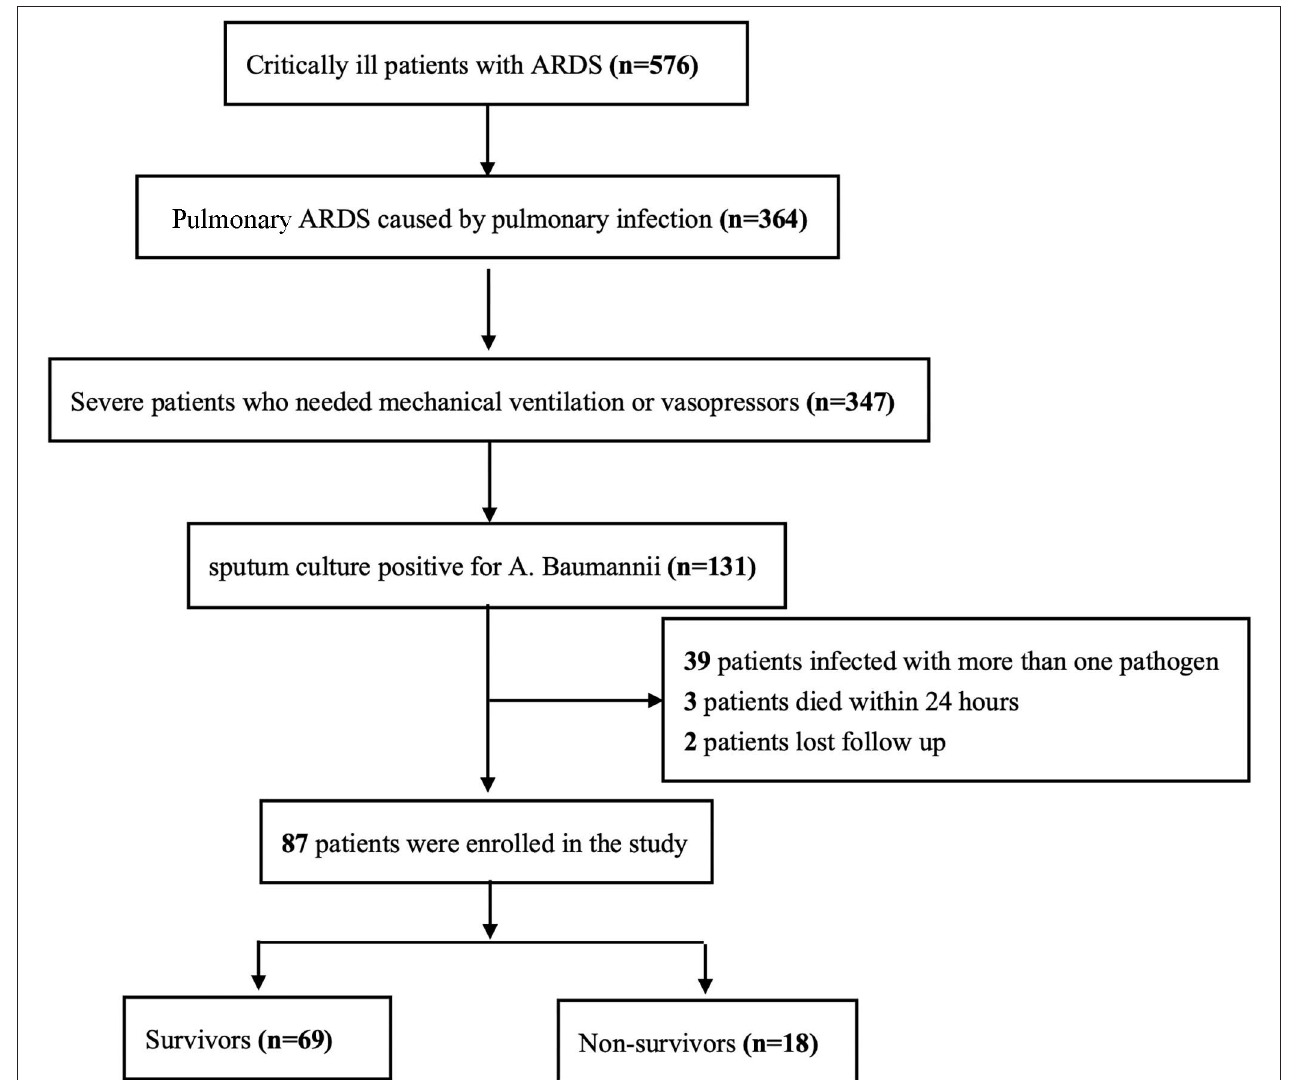
FIGURE 1 | Enrollment flowchart. A. baumanni, Acinetobacter baumannii .